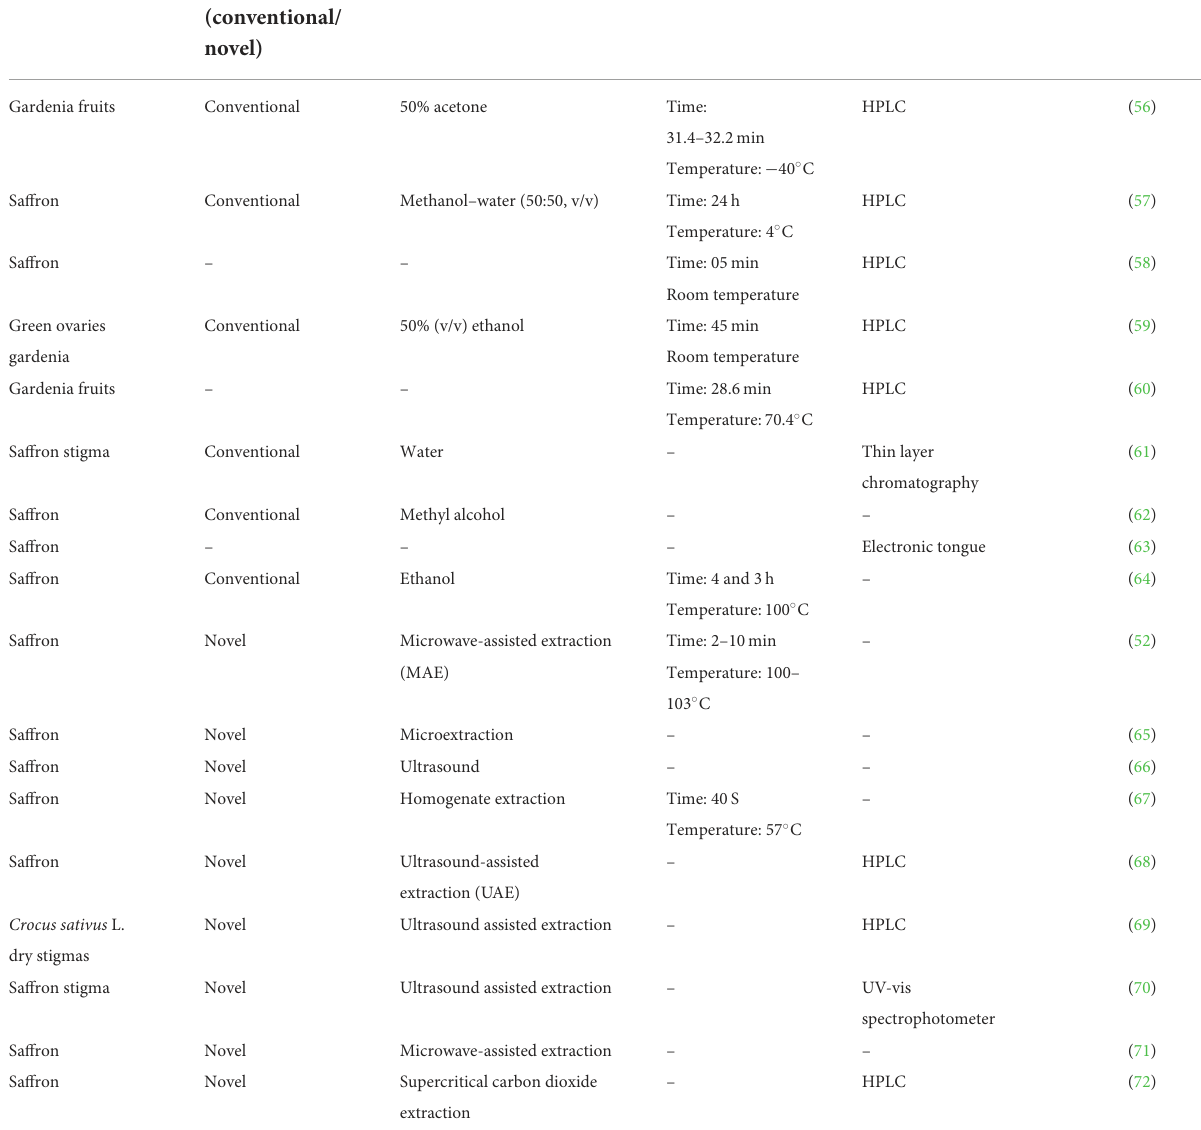
TABLE 1 Extraction and separation of